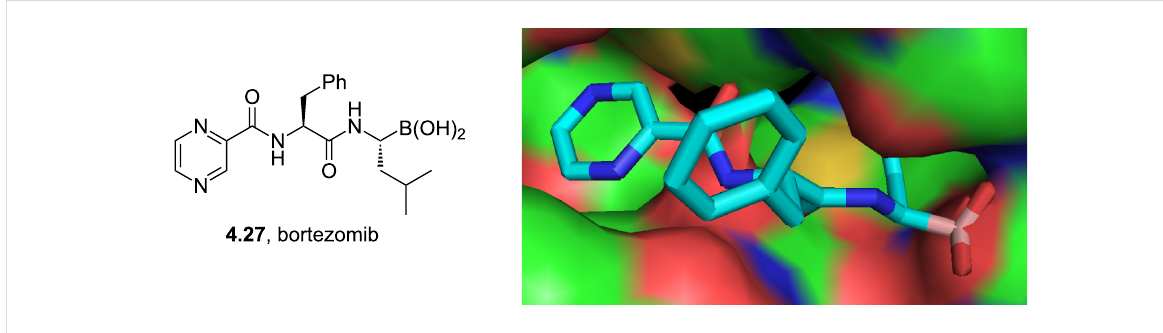
Figure 12: Bortezomib bound in an active site of the yeast 20S proteasome ([114], pdb 2F16).